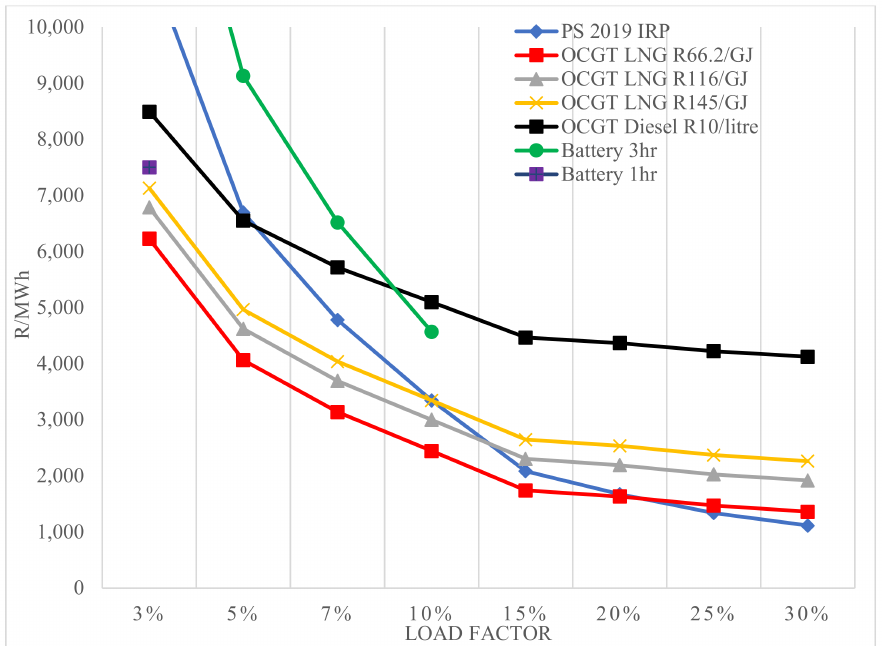
Figure 4. LCOE curves for IRP 2019 comparing PS (informed by Ingula), OCGT, and lithium- ion battery.